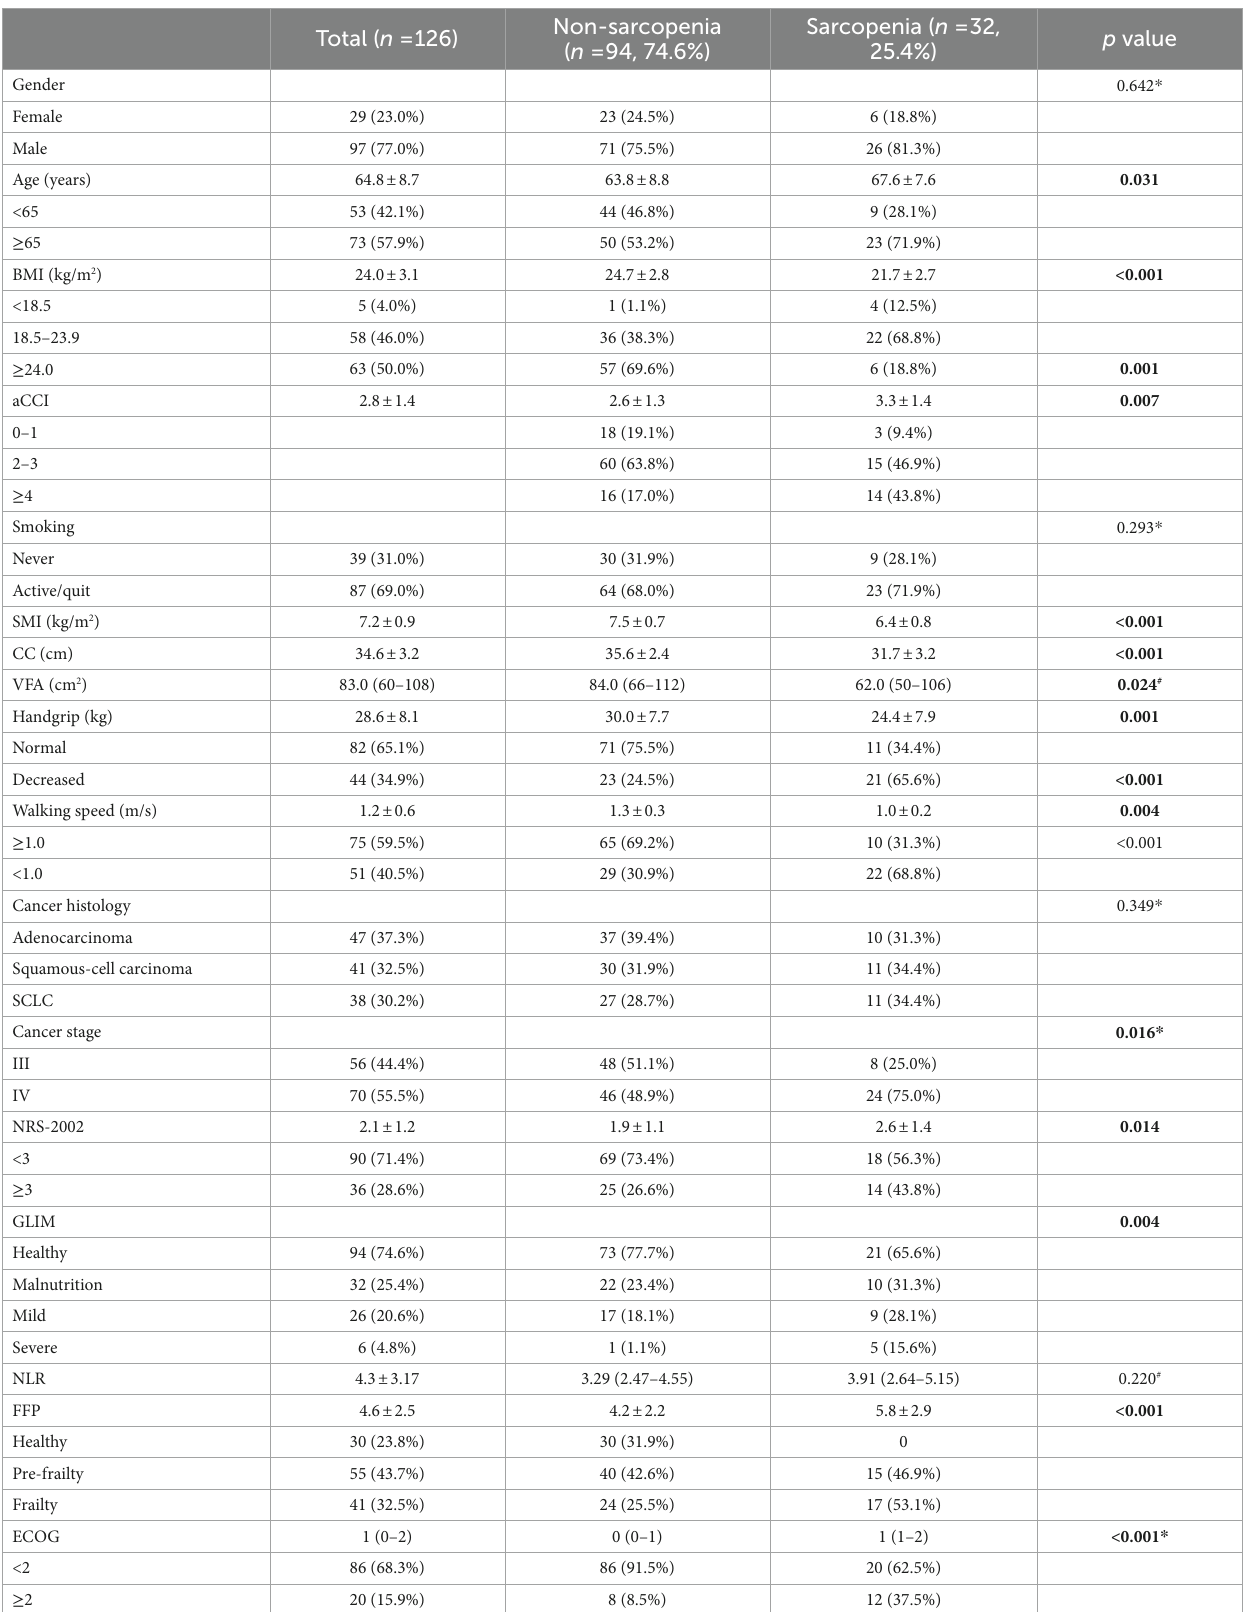
TABLE 2 Characteristics of demography and screening tools in participants with and without sarcopenia. Non-sarcopenia Total ( n = 126) ( n = 94,